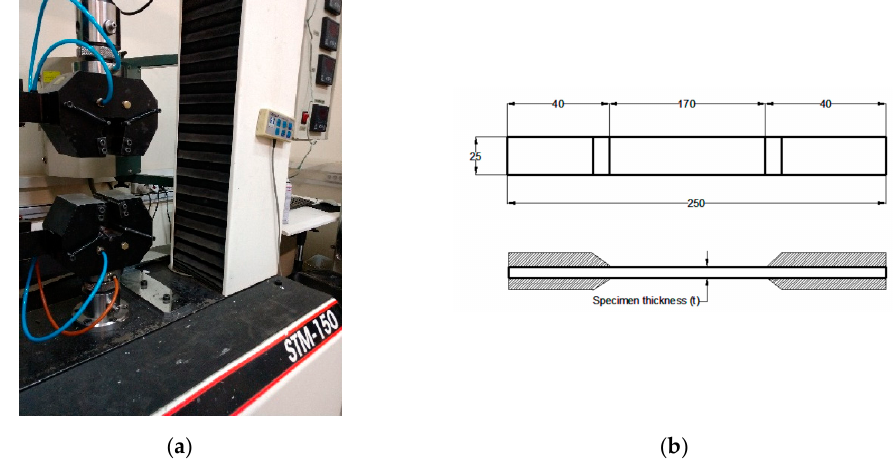
Figure 1. ( a ) The universal testing machine, SANTAM 150, and ( b ) specimen schematic based on the ASTM D3039 [37].